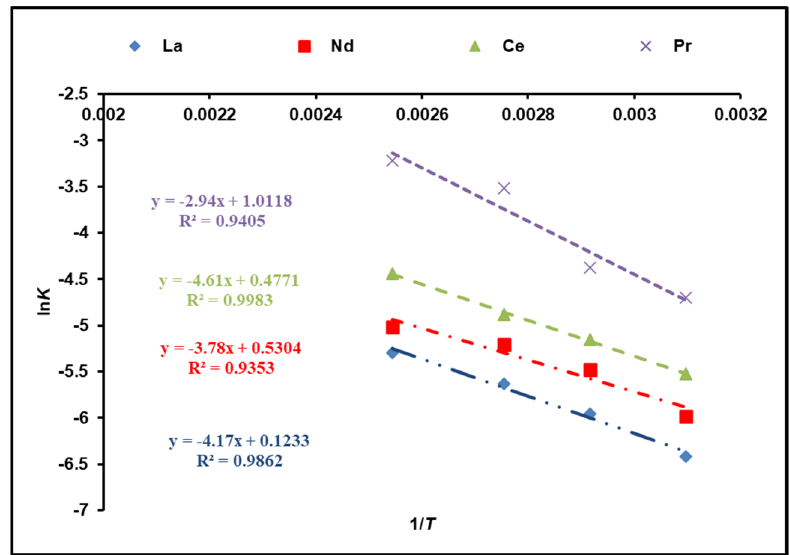
Figure 7. Influence of dissolution time on fraction of REEs dissolved, 1 − (1 − x ) 1/3 , at different temperatures.